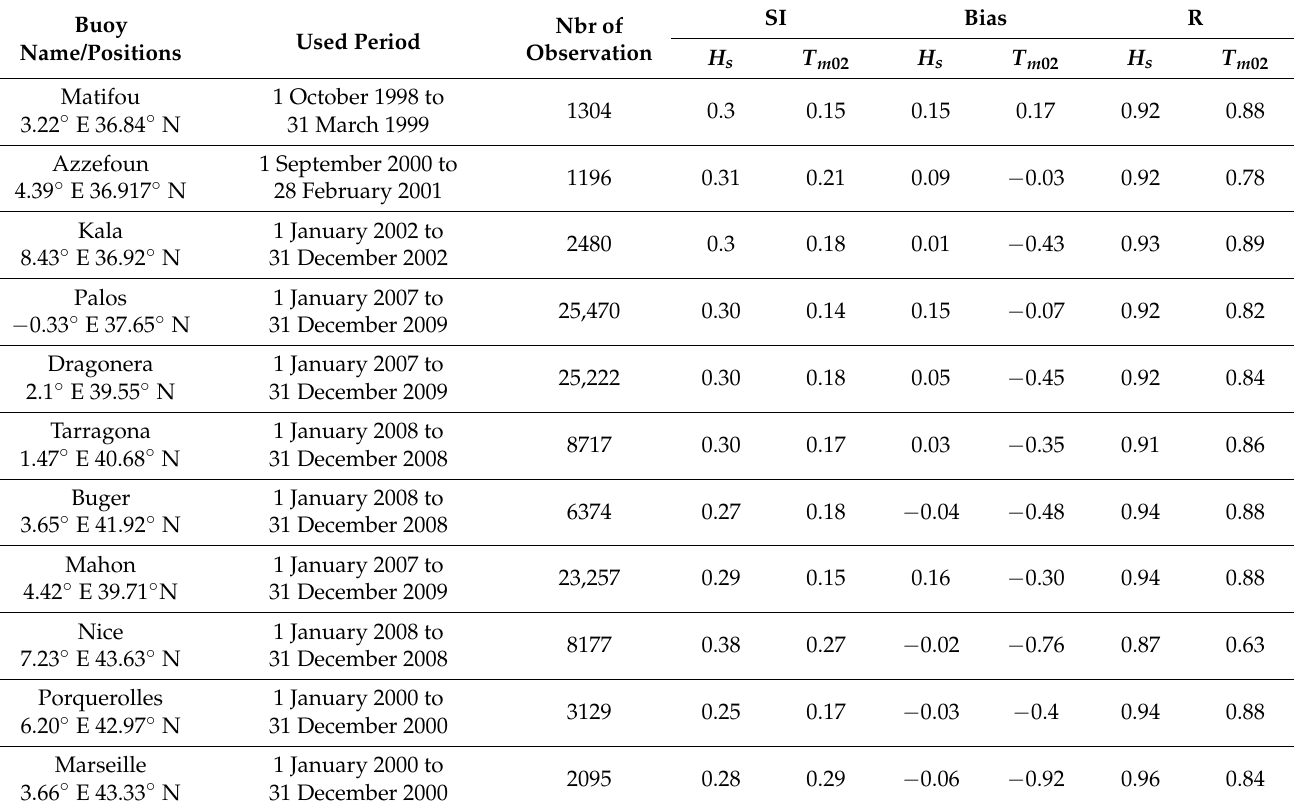
Table 2. Statistical error results obtained during the validation of SWAN coarse grid model [42,43].